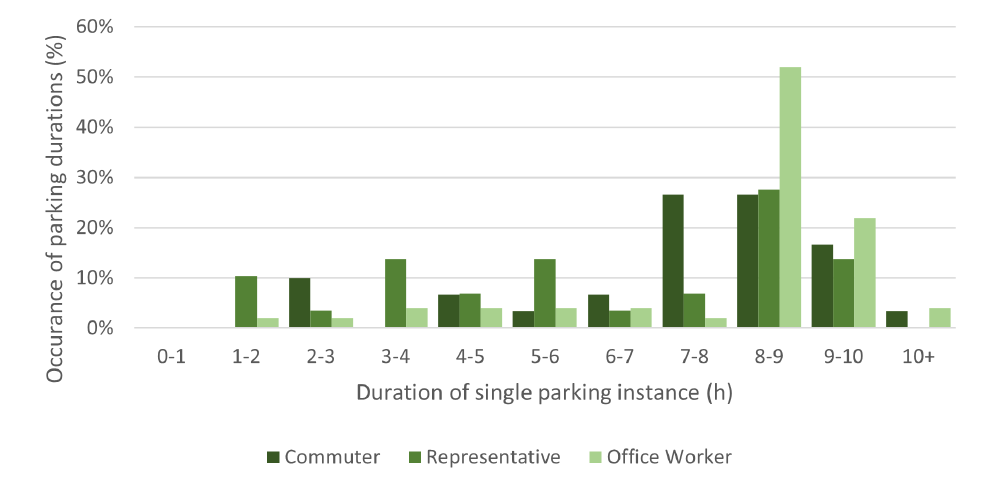
Figure 4. Histogram of duration (hours) of single parking instance at a company location.